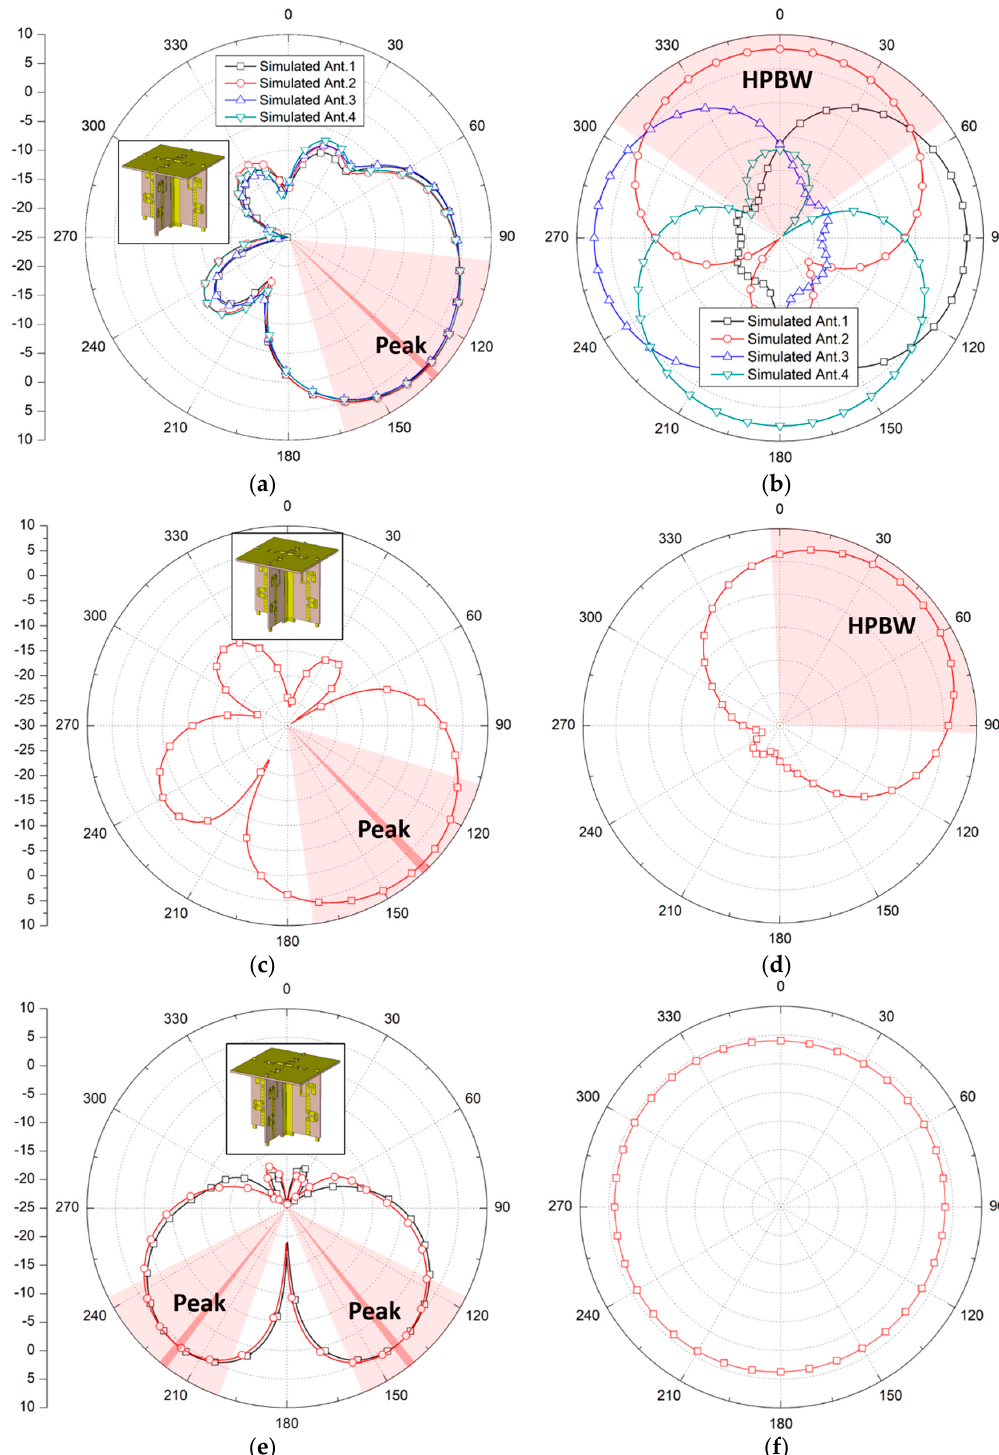
Figure 7. Simulated radiation patterns ( a ) and ( b ): an individual antenna, ( c ) and ( d ): two-antenna, and ( e ) and ( f ): four-antenna excitations in the elevation (left column) and azimuth (right column) planes.